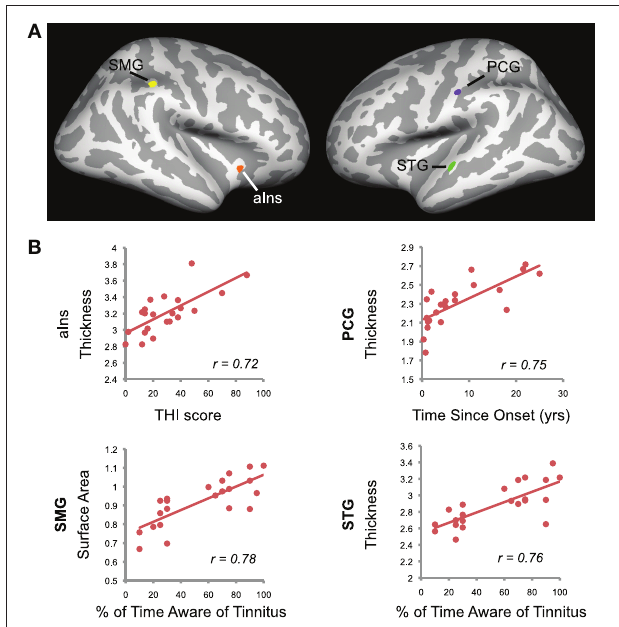
FIGURE 6 | Tinnitus characteristics and cortical anatomy. (A) Correlations between cortical morphology and tinnitus characteristics are displayed on the cortical surface. Positive correlation between tinnitus distress and cortical thickness in anterior insula (aIns) is shown in orange. Positive correlations between the percentage of time patients reported being aware of their tinnitus were present in two areas: supramarginal gyrus (SMG) surface area in yellow and superior temporal gyrus (STG) thickness in green. A purple cluster indicates a positive correlation between time since tinnitus onset and cortical thickness in postcentral gyrus (PCG). (B) Scatterplots show mean data for the clusters identified in (A) . Values are indicated for each tinnitus patient, with regression lines and Pearson’s r values shown.